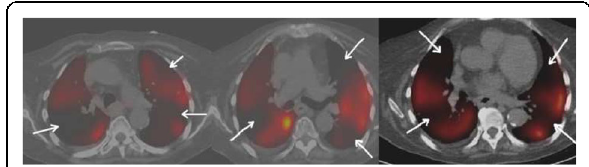
Fig. 19 SPECT perfusion scan in a patient with CTEPH. SPECT